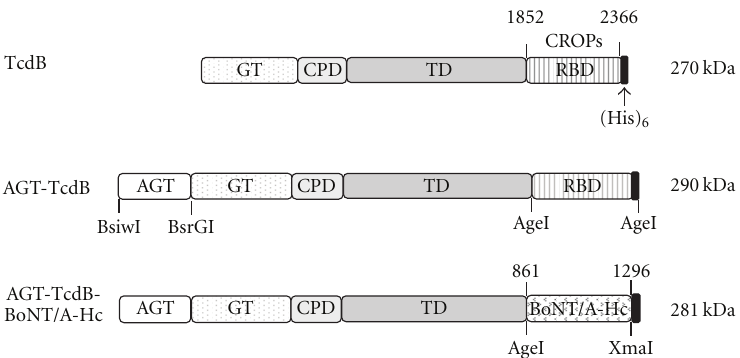
Figure 1: Engineered recombinant TcdB proteins. Native TcdB contains a glucosyltransferase domain (GT), a cysteine-protease domain (CPD), a translocation domain (TD), and a receptor-binding domain (RBD) as shown. The AGT-tag coding DNA was appended to the amino terminus in frame with the full-size TcdB coding DNA to create the AGT-TcdB expression vector. The TcdB RBD was replaced in frame with the full-size BoNT/A heavy chain carboxyl terminus (BoNT/A-Hc, amino acids 861–1296), containing the receptor-binding domain for BoNT/A, to generate AGT-TcdB-BoNT/A-Hc. The sizes of the boxes are approximately proportional to the sizes of the protein domains. Restriction sites used in preparing the constructions are